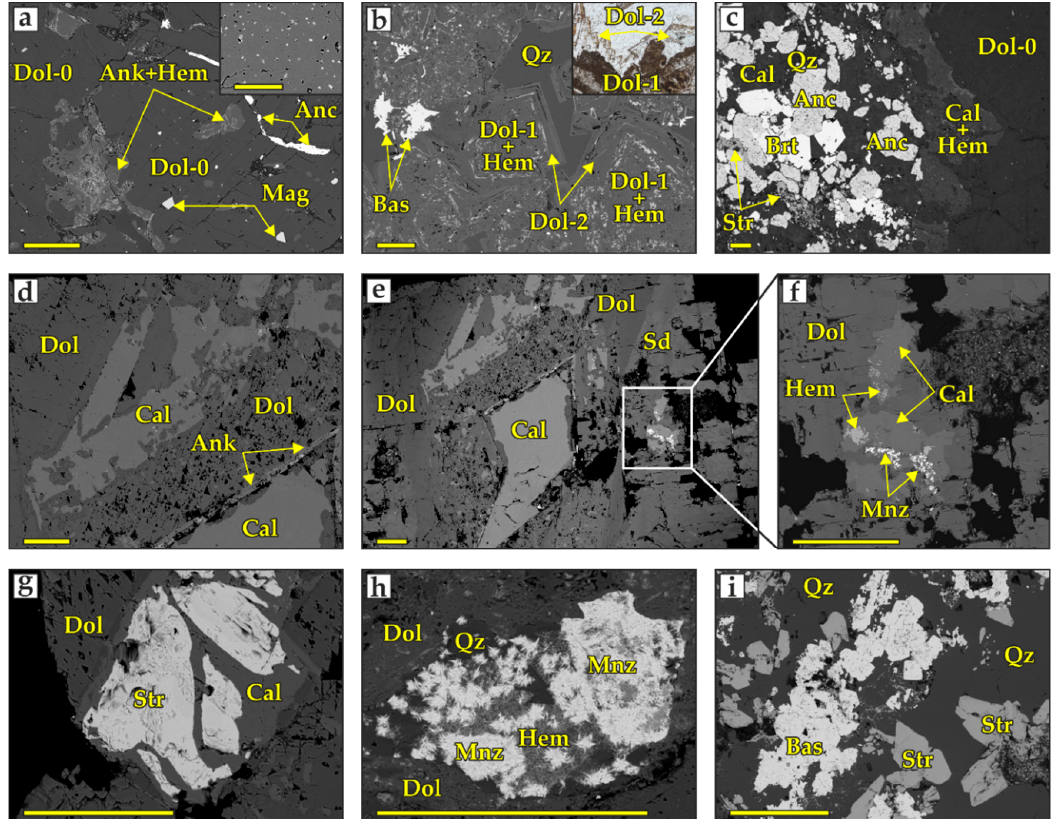
Figure 3 . The mineralogy of Petyayan – Vara magnesiocarbonatites. ( a ) The early dolomite (Dol-0) with inclusions of magnetite (Mag), calcite (dark grey inclusions in the insert), carbocernaite and/or burbankite (light grey inclusions in the insert); locally replaced by ankerite (Ank) and hematite (Hem); and ancylite-(Ce) (Anc) in the interstices between Dol-0 grains. ( b ) Rims of the optically transparent dolomite with a dense structure (Dol-2) around the optically turbid porous dolomite (Dol-1), containing hematite; the remaining space is filled by quartz (Qz) and bastnäsite-(Ce) (Bas); the insert shows the same in plane-polarized transmitted light. ( c ) Ancylite ore composed of ancylite-(Ce), baryte (Brt), early-generation strontianite (Str), calcite (Cal), and quartz; calcite and hematite jointly replace the Dol-0 near the border with ancylite ores. ( d ) Ankerite cross-cutting vein. ( e , f ) The replacement of dolomite by siderite (Sd) and calcite with micro-grain aggregates of hematite and monazite-(Ce) (Mnz). ( g ) Calcite with late strontianite. ( h ) The monazite-(Ce) forms needle mixture aggregates with hematite. ( i ) Microgranular aggregates of bastnäsite-(Ce) and hydroxylbastnäsite-(Ce) (Bas) surrounded by grains of quartz and late strontianite. All photomicrographs, except for the insertion in Figure 3b, were imaged in backscattered electron (BSE) mode. Scale bar is 200 μ m for all images.